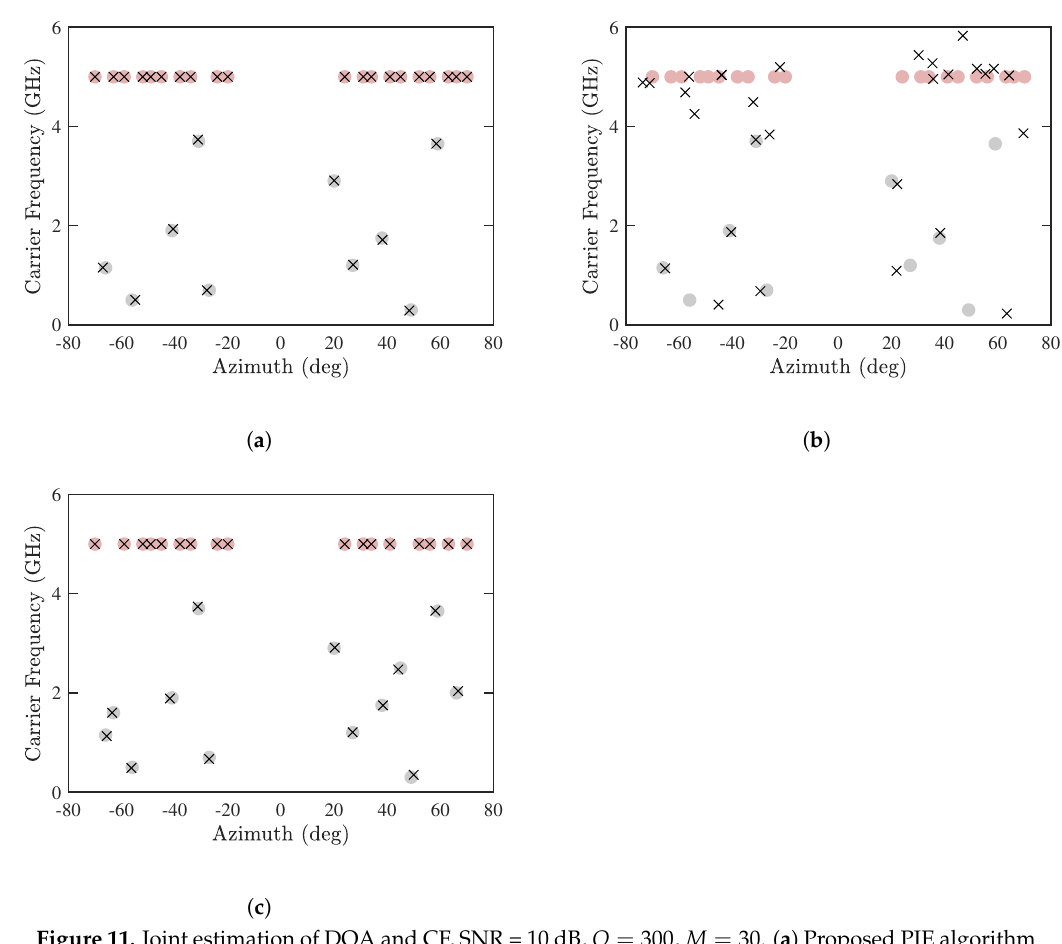
Figure 11. Joint estimation of DOA and CF, SNR = 10 dB, Q = 300, M = 30. ( a ) Proposed PJE algorithm with M u = 10, ( b ) conventional JE algorithm with M u = 10, ( c ) proposed PJE algorithm with M u =